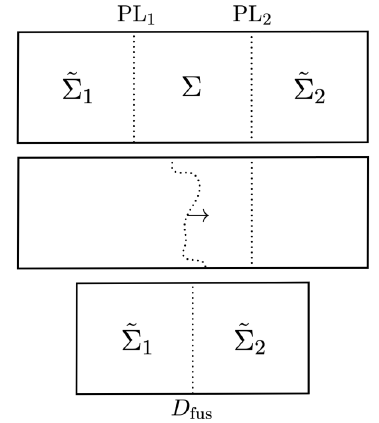
Figure 1 . When an algebra admits two Drinfel’d double one can fuse the associated Poisson-Lie T-duality defects PL i separating the sigma-models Σ → G with ˜Σ i → ˜ G i , for i = 1 , 2